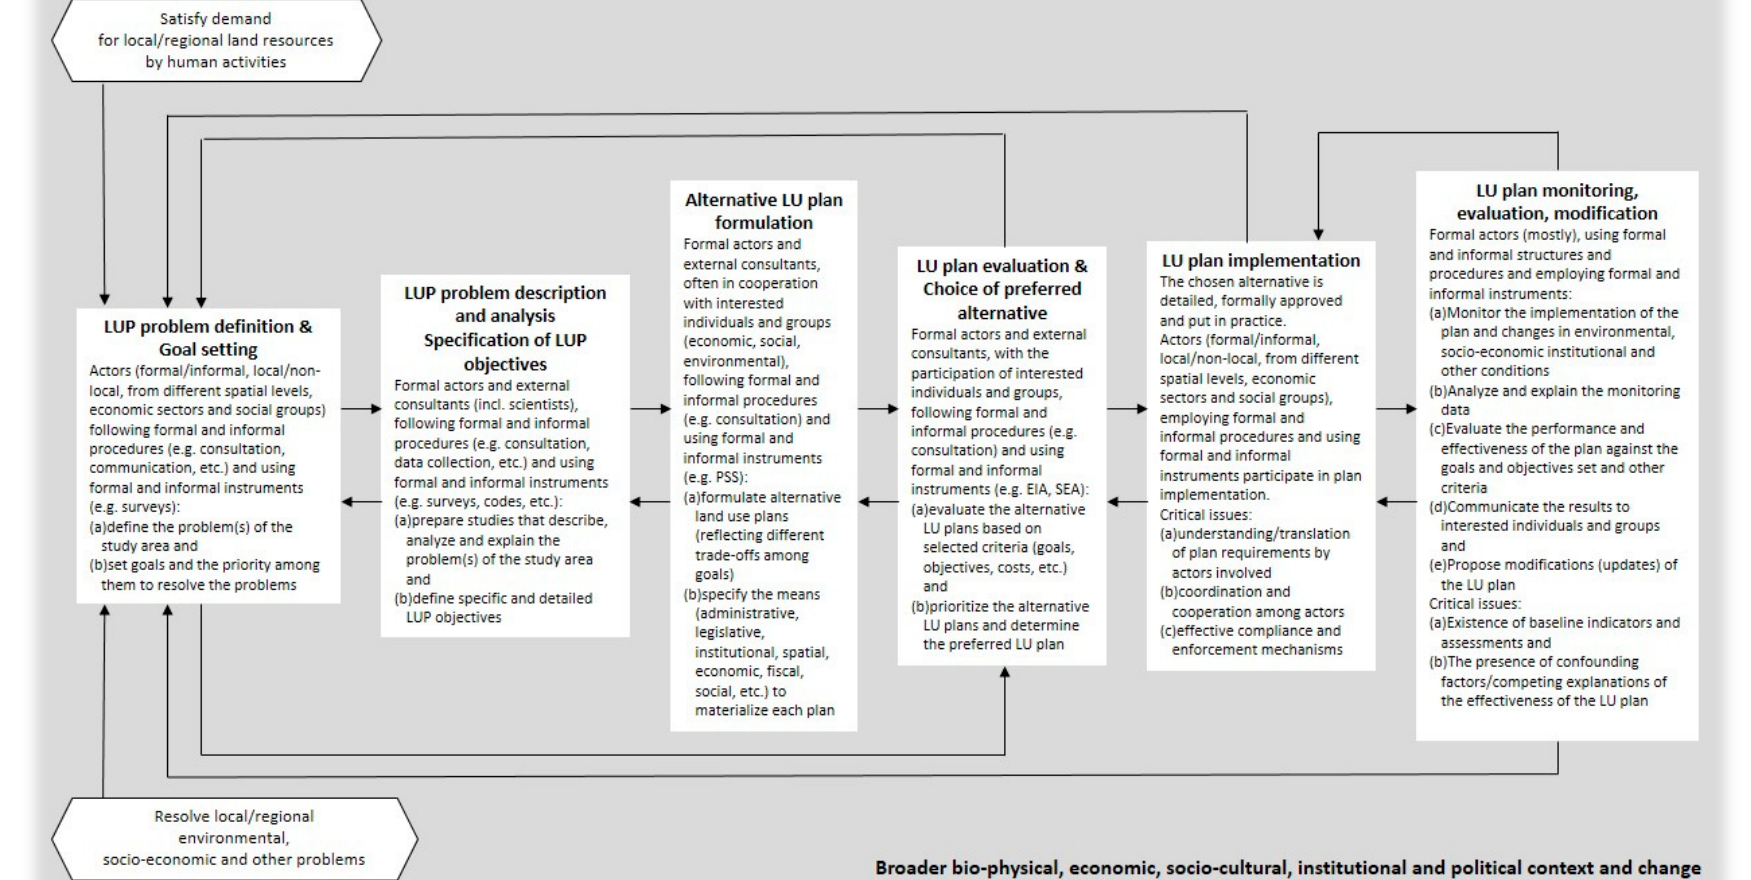
Figure 1. Schematic presentation of the land-use planning (LUP) process and description of the